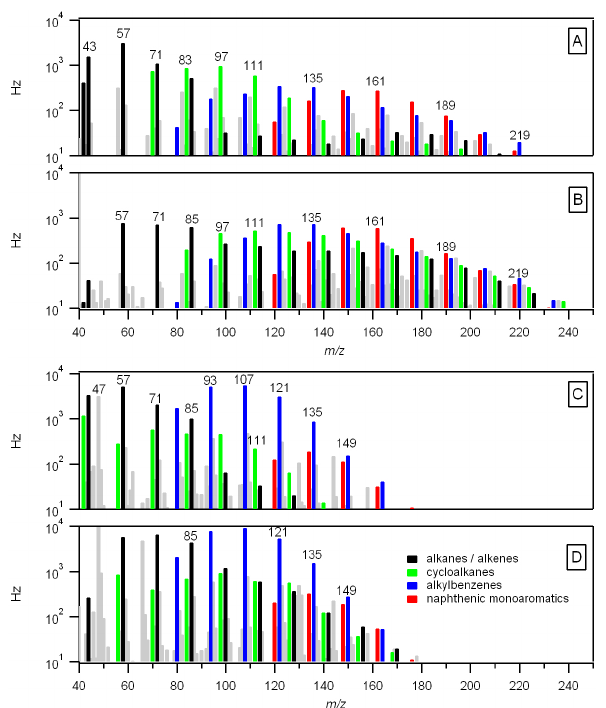
Fig. 4. PTR-MS mass spectrum of diesel fuel no.2 at 120Td (A) and 80Td (B) and gasoline at 120Td (C) and 80Td (D) . Ion signal has been color-coded to identify organic compound